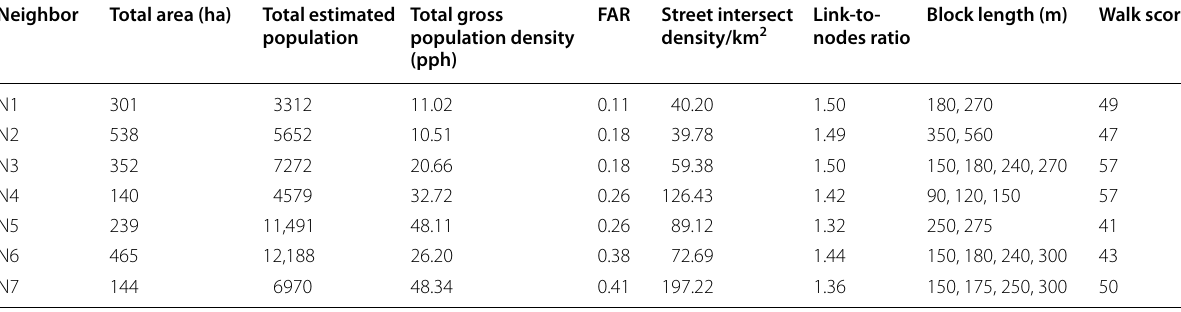
Table 5 Macroscale urban morphological measures and the recorded UMI Walkscores